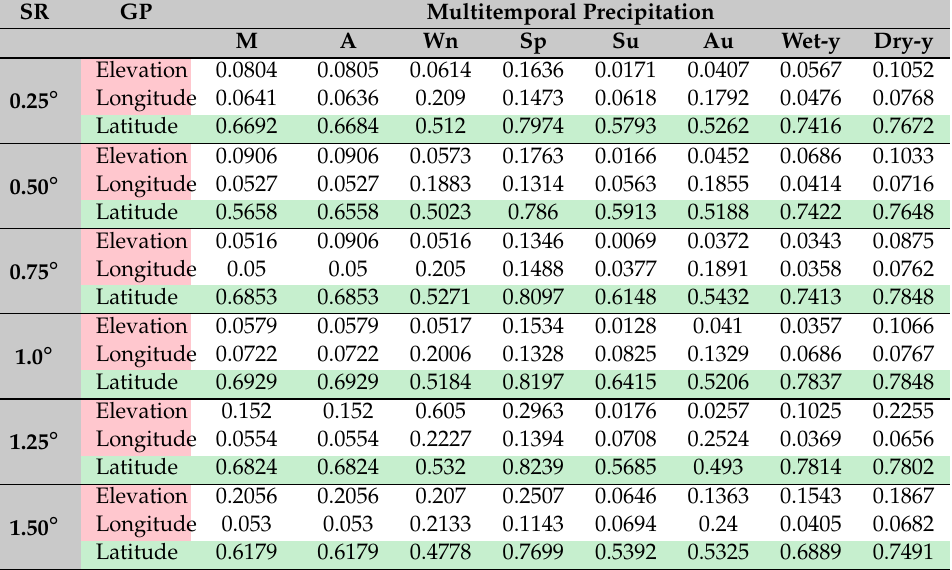
Table 1. Output of model fitting between the multitemporal GPM variables and geospatial predictors. SR